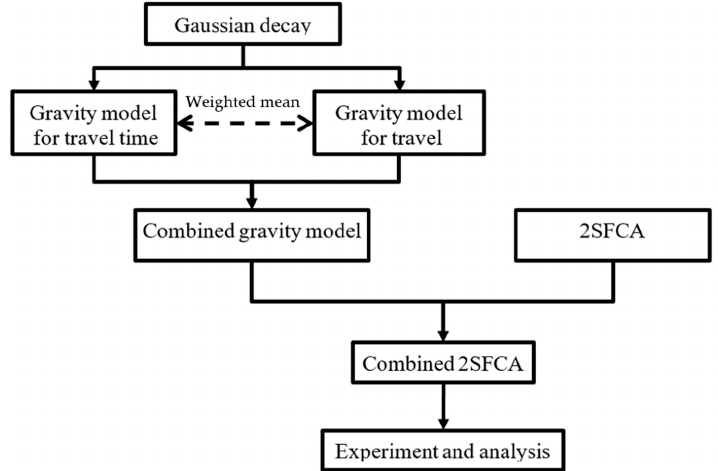
Figure 1. Flowchart of the study of accessibility analysis.